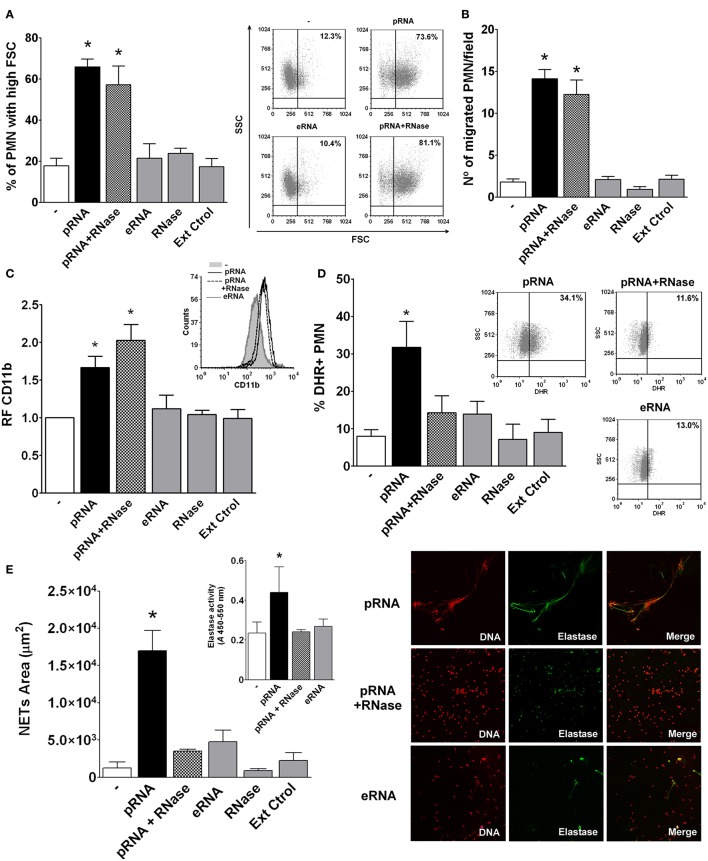
Prokaryotic RNA (pRNA) directly activated PMN. Isolated PMN were treated with purified pRNA, eukaryotic RNA (eRNA), or pRNA treated with RNase. Controls of RNase alone or an extraction control (Ext Ctrol), using water instead of bacteria, were also included. (A) Percentage of PMN with high FSC. Results were expressed as the mean ± ES, n = 15. Right panel: representative dot-plots showing SSC vs. FSC profiles of PMN with no treatment (−), pRNA, eRNA, or pRNA+RNase. (B) Chemotactic response. Results were expressed as the mean ± ES, n = 7. (C) Expression of CD11b. Results were expressed as the mean ± ES of the relative fluorescence (RF) of the MFI of the different treatments with respect to untreated PMN, n = 7. Right panel: Representative histogram of the expression of CD11b in untreated PMN (−), or PMN incubated with pRNA, eRNA, and pRNA+RNase. (D) ROS generation. Results were expressed as the mean ± ES, n = 8. Right panel: Representative dot-plots of the percentage of DHR+ PMN incubated with pRNA, pRNA+RNase, or eRNA. (E) NETs formation. Results were expressed as the mean ± ES, n = 9. Inset: Elastase activity for untreated PMN (-), or pRNA, pRNA+RNase, and eRNA treatments. Results were expressed as the mean ± ES, n = 9. Right panel: Representative microphotographs of confocal images showing PMN from pRNA, pRNA+RNase, and eRNA groups stained for DNA or elastase visualization and the merge of the images (x200). In all cases *p < 0.05 vs. all other groups.